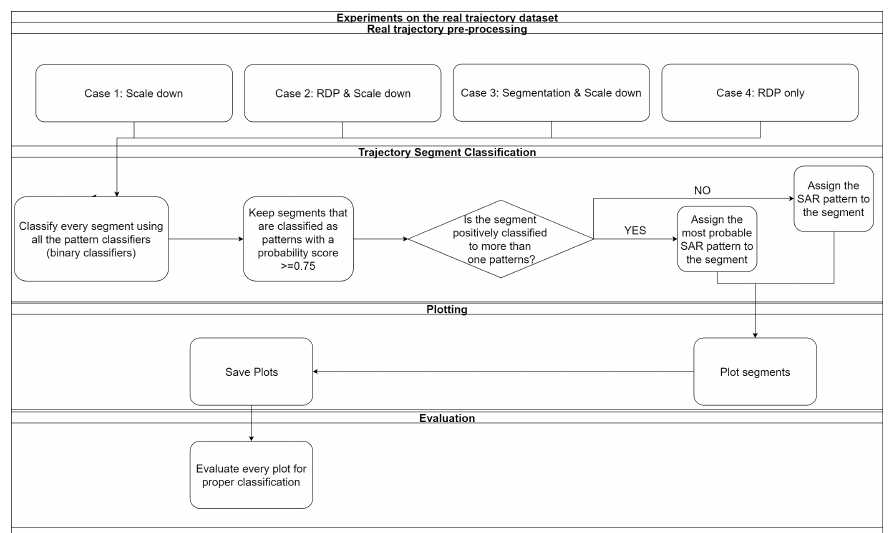
Figure 5. The different strategies of pre-processing real trajectories, the classification and evaluation of